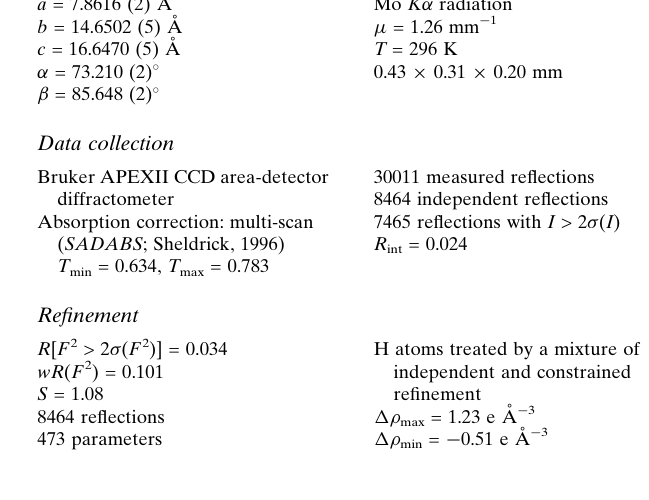
disorder in main residue; R factor = 0.034; wR factor = 0.101; data-to-parameter ratio = 17.9. Data collection